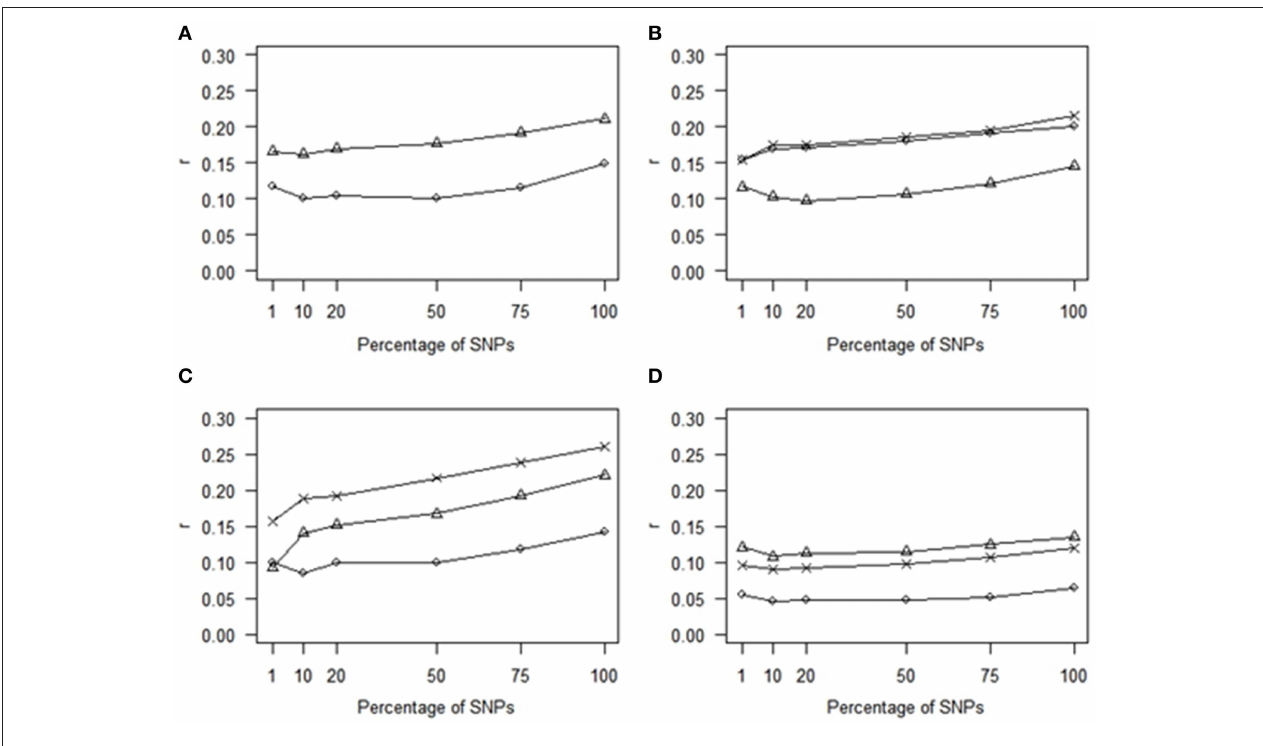
FIGURE 2 | Comparison of correlations ( r ) for GWAS-markers. GBLUP was tested by estimating effects in the validation populations of the top SNPs identified by GWAS analysis performed in the training populations. Traits presented are (A) HS (circles) and THS